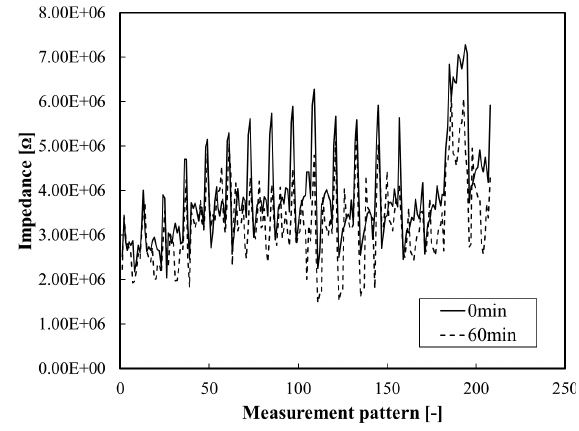
Fig. 6. The magnitude of impedance at 0 min and 60 min on Day